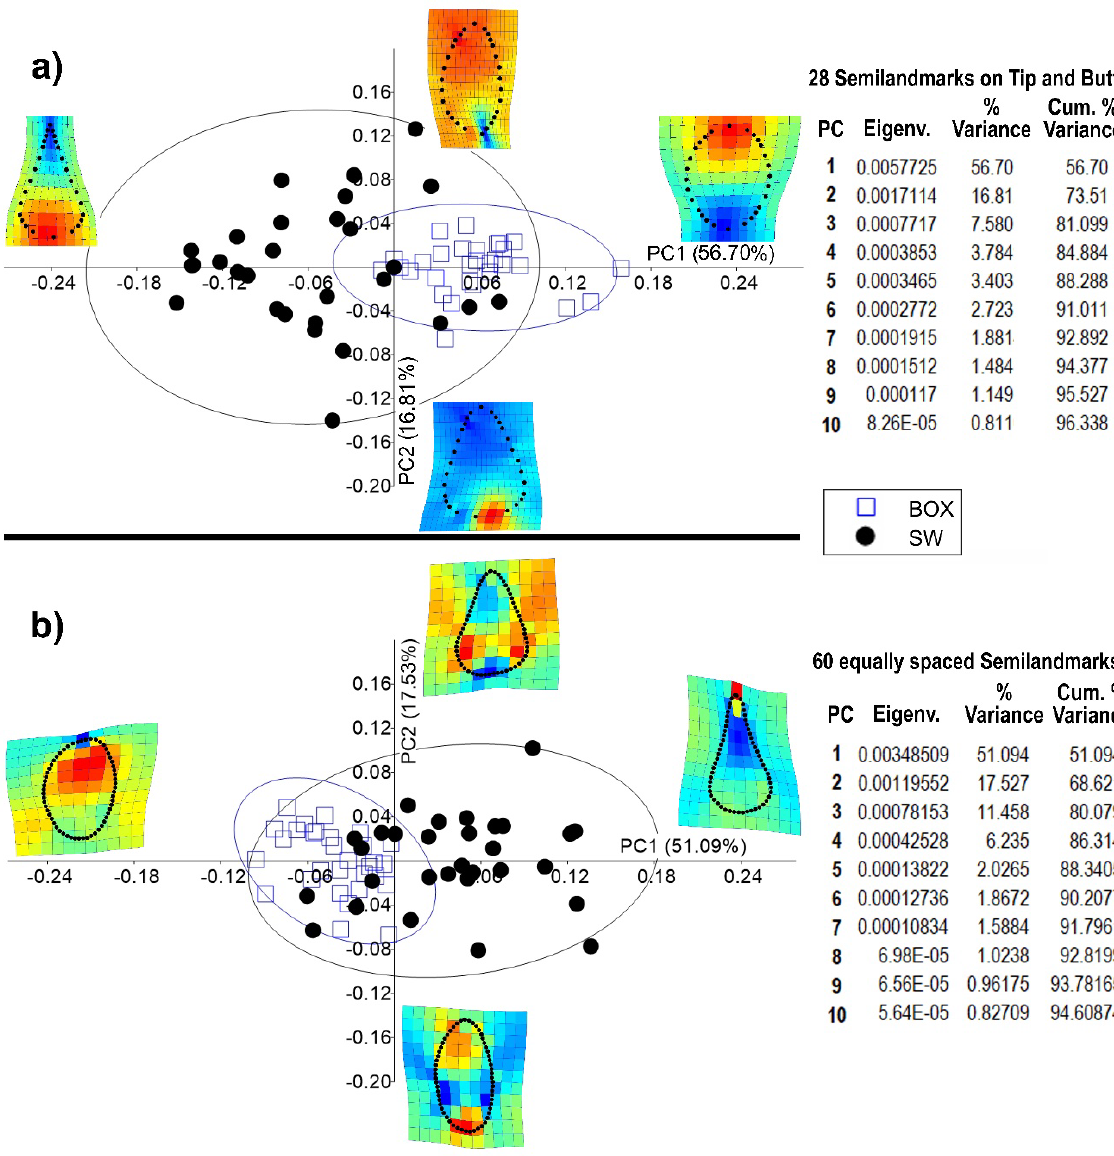
Figure 5. Principal components scatter plots of handaxes from Boxgrove (blue square) and Swanscombe (Black dots). Outlines on 2D images, made on 28 semi-landmarks (upper), and on 60 equally spaced semi-landmarks (lower) with their percentages of cumulative variance of each